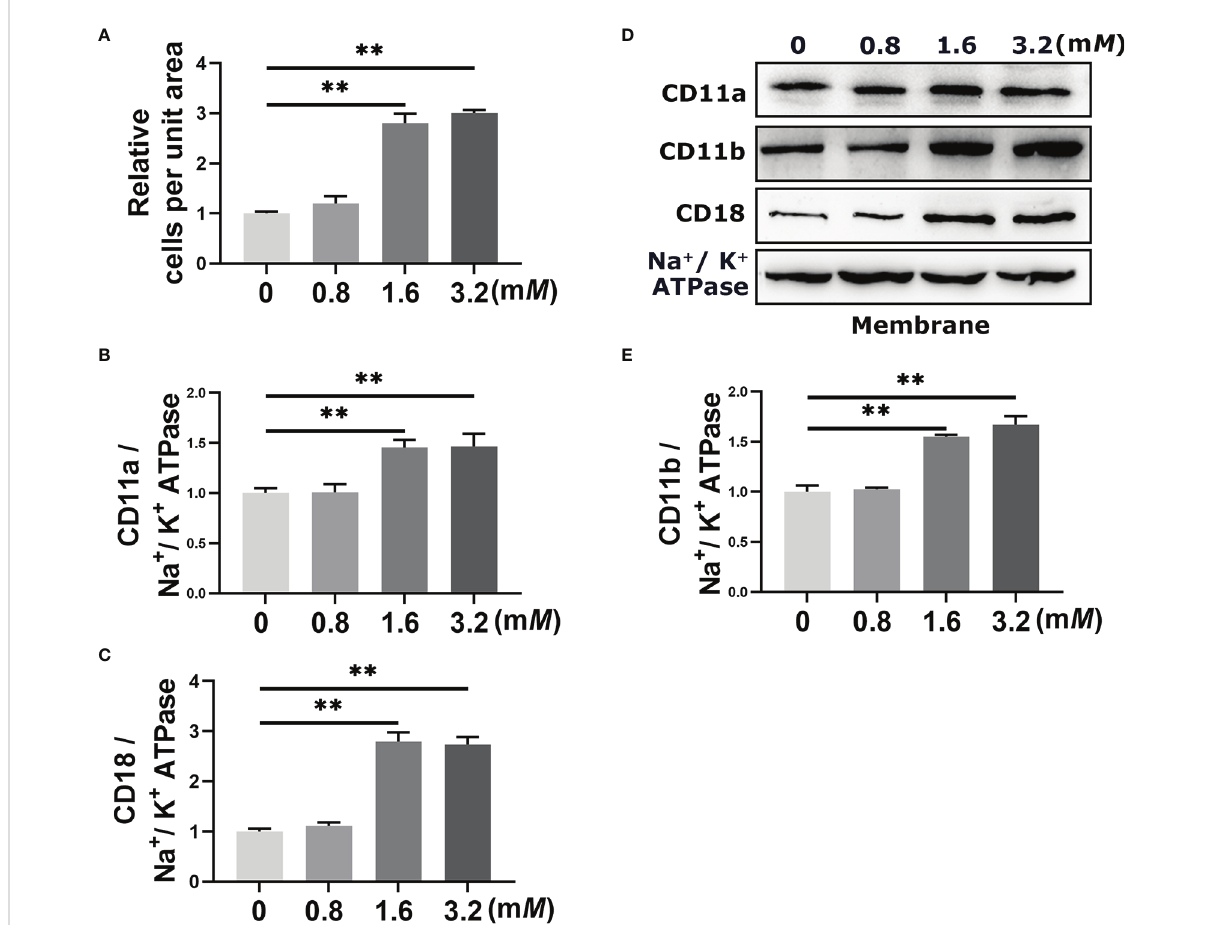
FIGURE 2 Effect of BHB with different stimulated concentrations on the adhesion of bovine neutrophils. Neutrophils were treated with 0 m M , 0.8 m M , 1.6 m M , and 3,2 m M BHB for 2 h, respectively. (A) Quantitation of the number of adherent neutrophils. (B-E) Protein abundance of membrane CD11a, CD11b, and CD18. Representative blots in both groups were shown in (B) The quanti fi cation was shown in C-E. For WB experiments, Na + /K + ATPase was used to normalize membrane protein abundance. Data were expressed as the mean ± SEM. Data were analyzed with a one-way ANOVA with subsequent Bonferroni correction. ** P < 0.01 as statistically highly signi fi cant. BHB, b -hydroxybutyrate; CD11b, integrin alpha-M precursor; CD11a, integrin alpha-L precursor; CD18, integrin beta-2 precursor; SEM, standard error of the